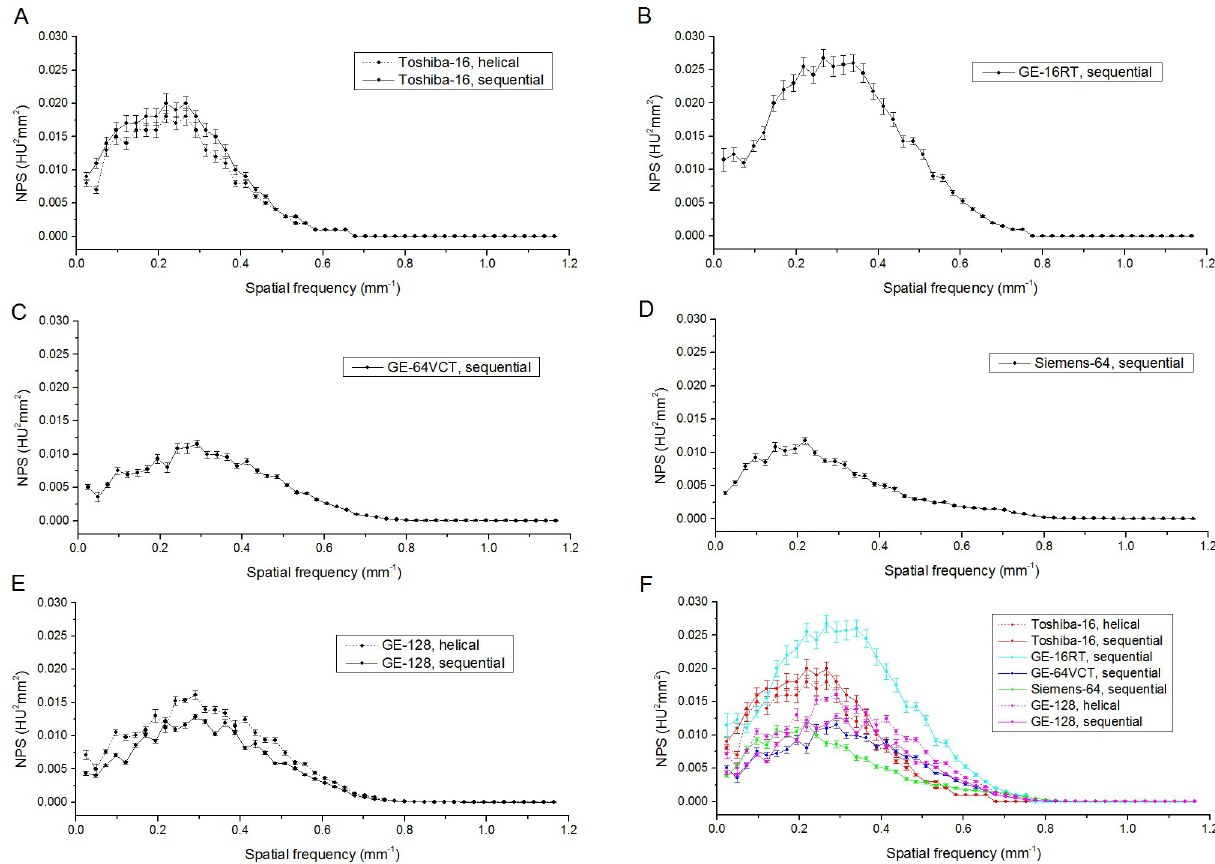
Fig 2. Noise power spectrum (NPS) of images acquired using different CT scanners/acquisitions protocols. Panels A, B, C, D and E show the NPS curves (mean ± standard deviation across five repeated measurements) for Toshiba-16, GE-16RT, GE-64VCT, Siemens-64 and GE-128 scanners, respectively. In order to better compare the different NPS curves, panel F shows on the same graphic the NPS curves for all scanners/acquisition protocols.